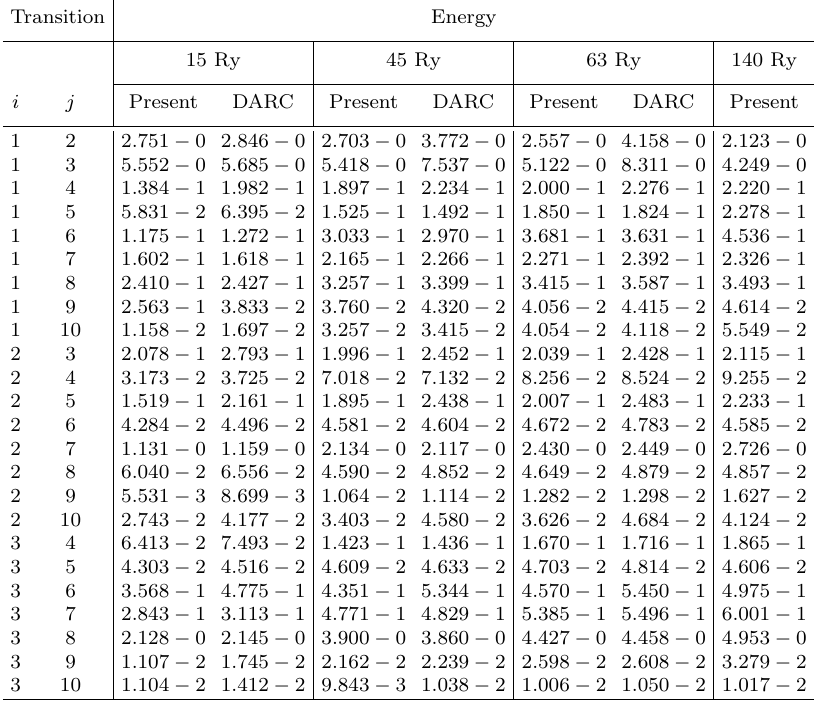
Table 2. O VI collision strengths, compared to R-matrix DARC